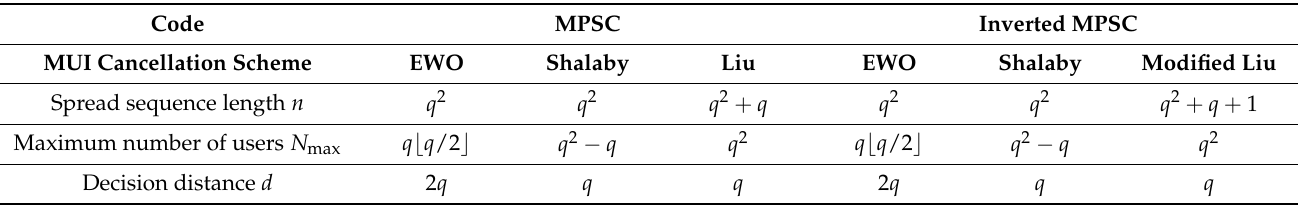
Table 3. Properties of MUI cancellation schemes.